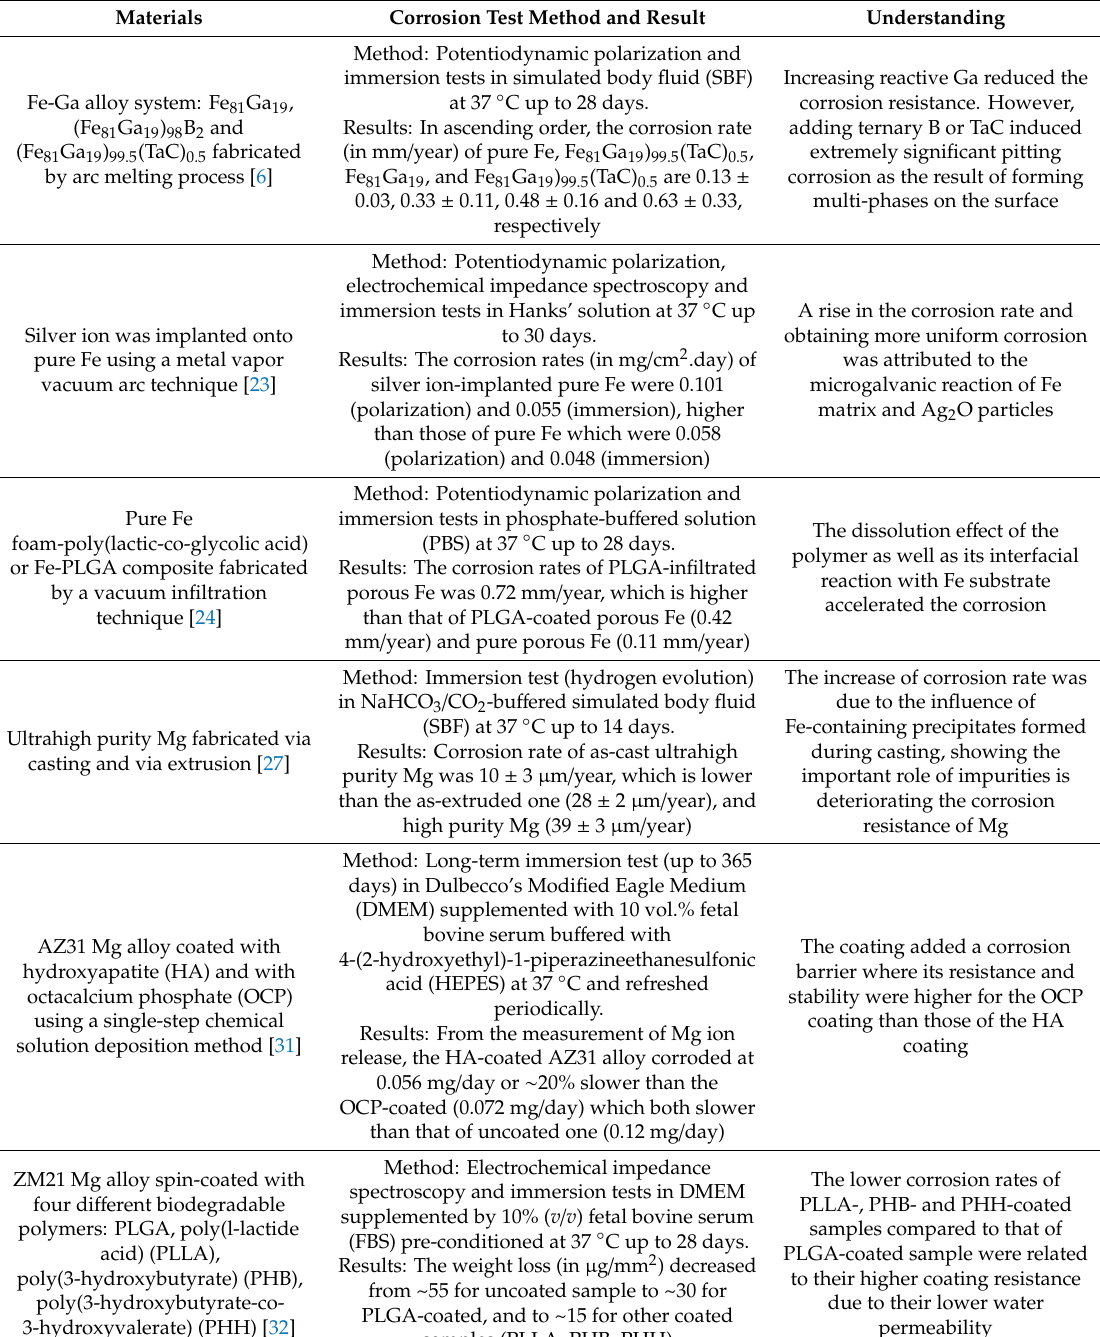
Table 1. Examples of corrosion control methods for absorbable